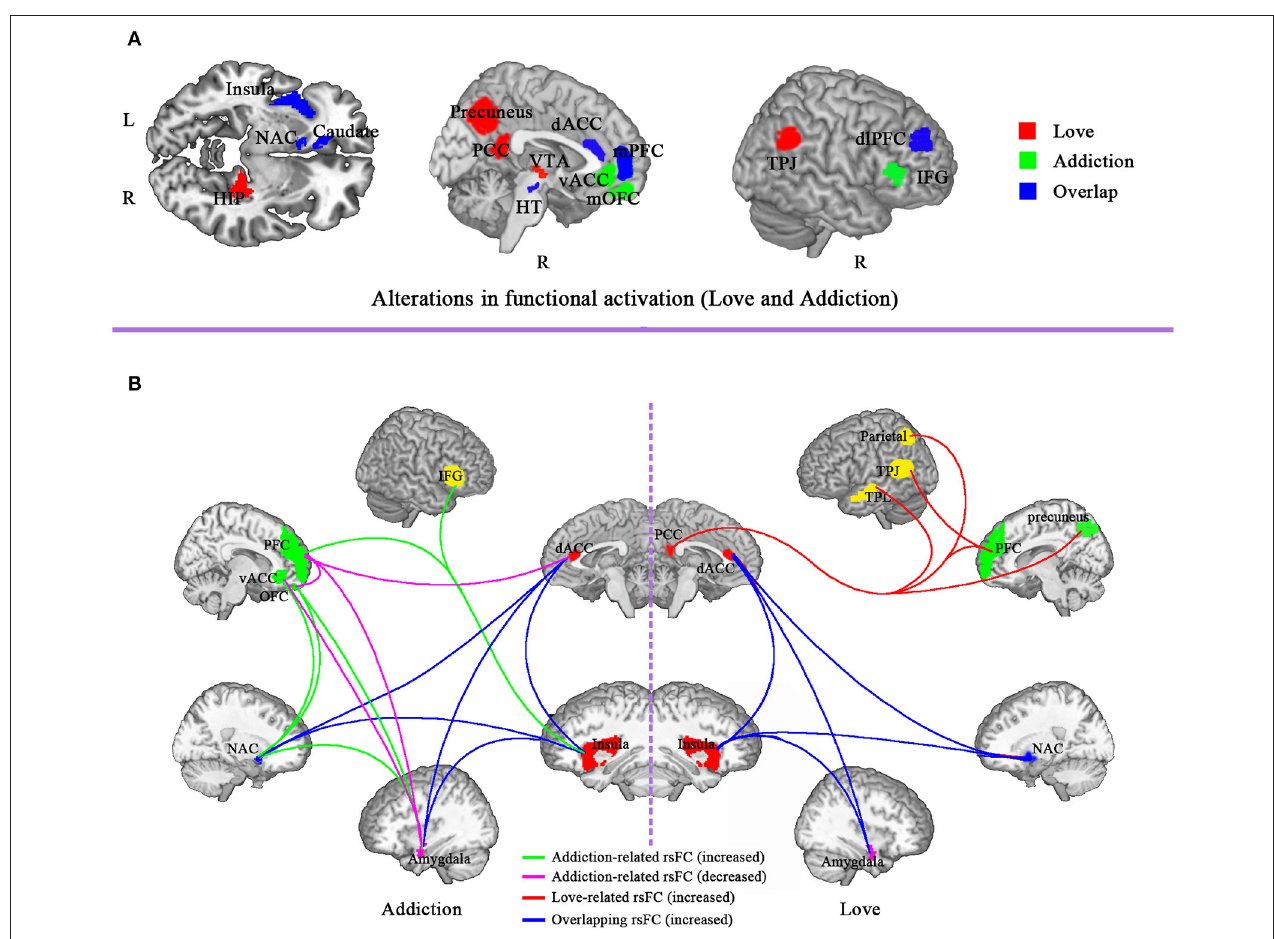
FIGURE 1 | Comparison of brain functional alteration between drug addiction and romantic love. (A) Alterations in functional activation in brain regions involved in love and addiction. Red, love-related functional activation; green, addiction-related functional activation; blue, overlap of functional activation for love and addiction. (B) Alterations in resting-state functional connectivity (rsFC) for love and addiction. Green, addiction-related functional connectivity increase; Red, love-related functional connectivity increase; blue, overlap functional connectivity increase for love and addiction; purple, addiction-related functional connectivity decrease. ACC, anterior cingulated cortex; vACC, ventral anterior cingulate; dACC, dorsal anterior cingulate cortex; PCC, posterior cingulate cortex; OFC, orbitofrontal cortex; IFG, inferior frontal gyrus; dlPFC, dorsolateral prefrontal cortex; PFC, prefrontal cortex; VTA, ventral tegmental area; NAC, nucleus accumbens; TPJ, temporo-parietal junction, HIP, hippocampus; HT, hypothalamus; TEP, temporal